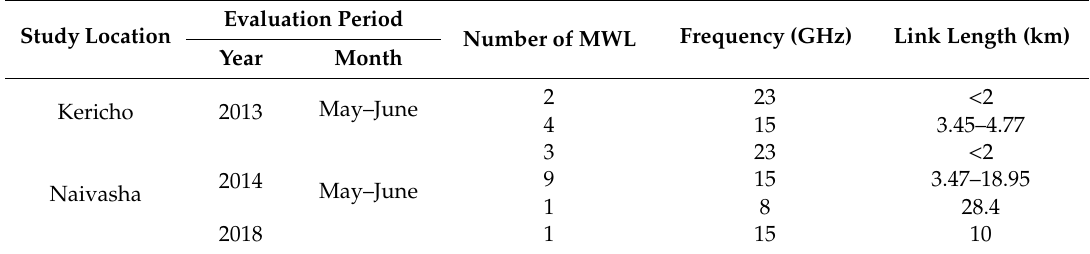
Table 1. Characteristics of the MWL network used in each study location.